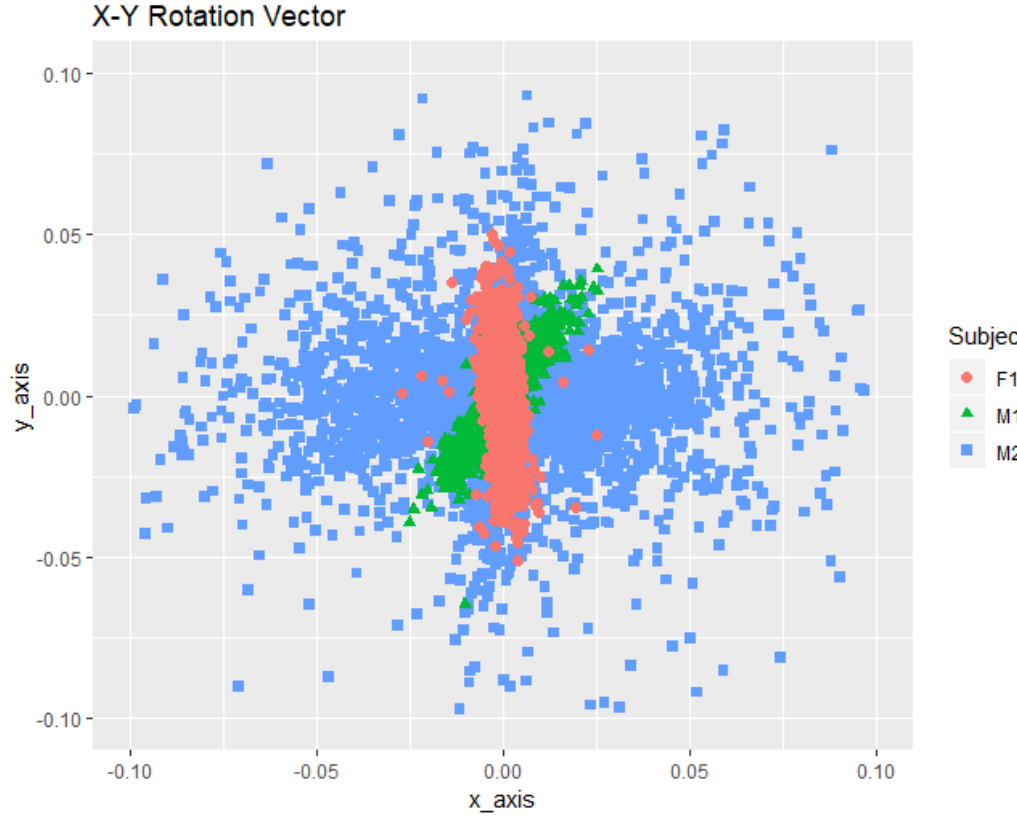
Figure 9. X-Y rotation vector. F1: healthy female; M1: healthy male; M2: male with back pain.